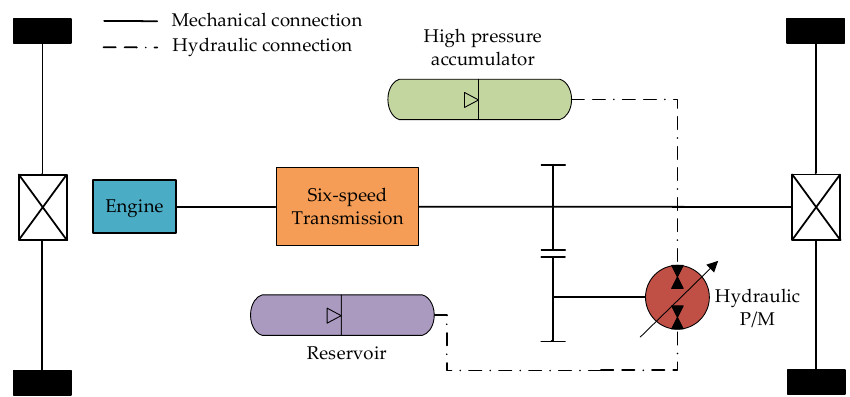
Figure 4. Structural diagram of hydraulic hybrid vehicle.